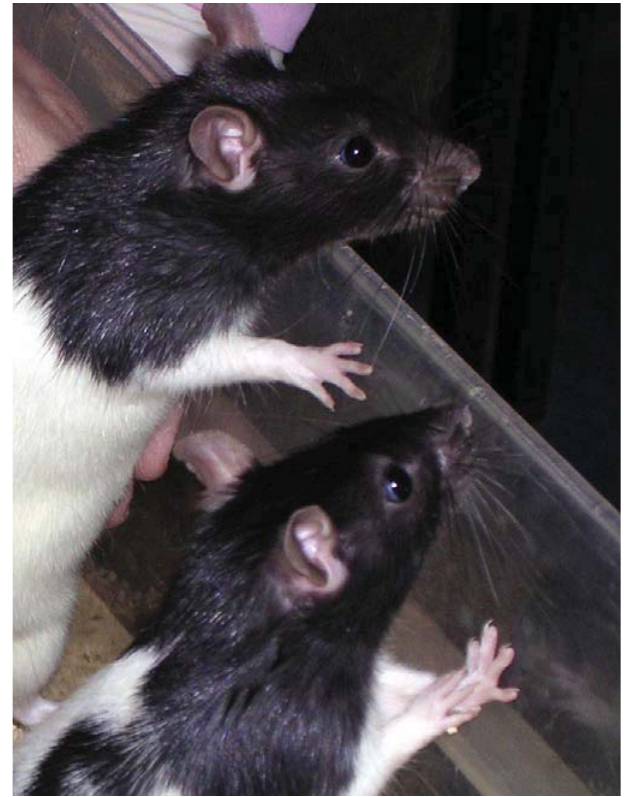
Figure 5. Two outbred laboratory rats, of the Lister Hooded (Long–Evans) strain.